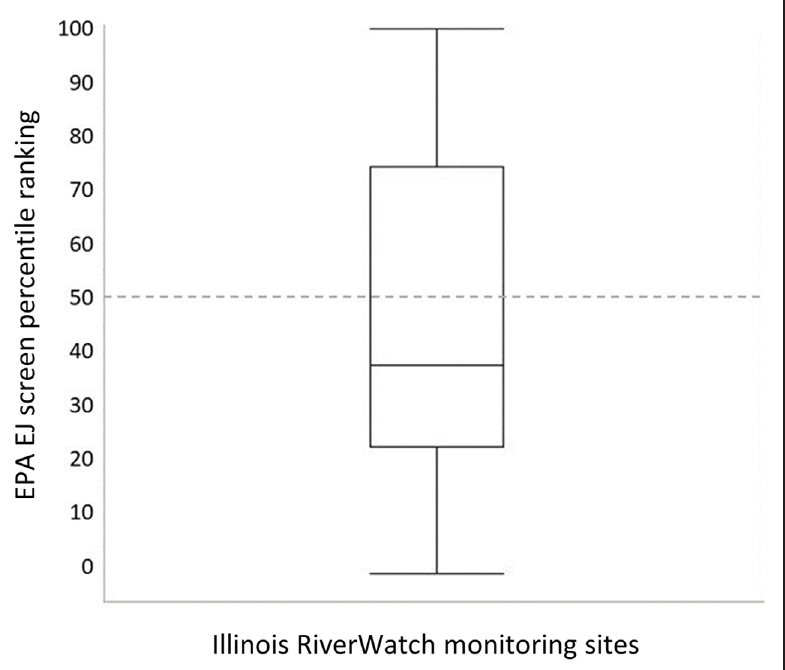
Figure 4: Percentile rankings from United States Environmental Protection Agency (US EPA) wastewater discharge environmental justice (EJ) index values of all RiverWatch sites, showing the distribution as compared to a refer- ence line at the 50 th percentile. Only 13 of our sites are in located in EJ hotspot areas with rankings above the 90 th percentile (N = 933, Mean ± sd = 43.7 ± 26, Median =